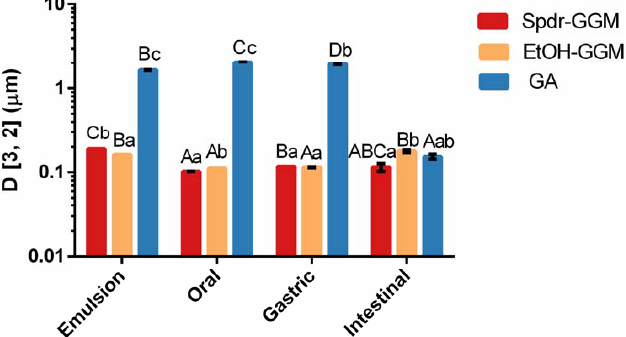
Figure A1. The D [3, 2] for Spdr-GGM-, EtOH-GGM-, and GA-stabilized emulsions during in vitro digestion. The capital letters compare the gastrointestinal stages, and the lowercase letters compare the emulsions (Dunnett T3 test, p < 0.05). Foods 2020 , 9 , x FOR PEER REVIEW